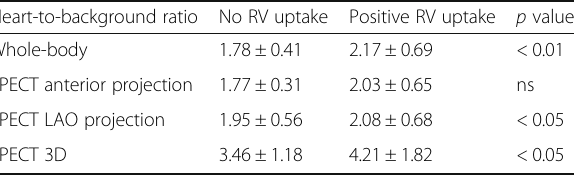
Table 4 Heart-to-background uptake ratio according to the right ventricular (RV)